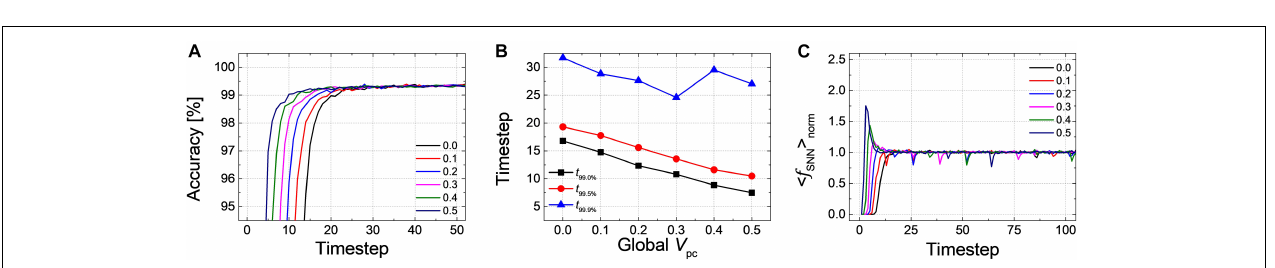
FIGURE 3 | (A) Result of accuracy-timestep for Net 1 with the global V pc varying from 0.0 to 0.5 with 0.1 steps. (B) Extracted timesteps ( t 99 . 0% , t 99 . 0% , and t 99 . 9% ) with respect to the amount of the global V pc . (C) The average firing rate in the output layer with the different levels of the global V pc according to the simulation